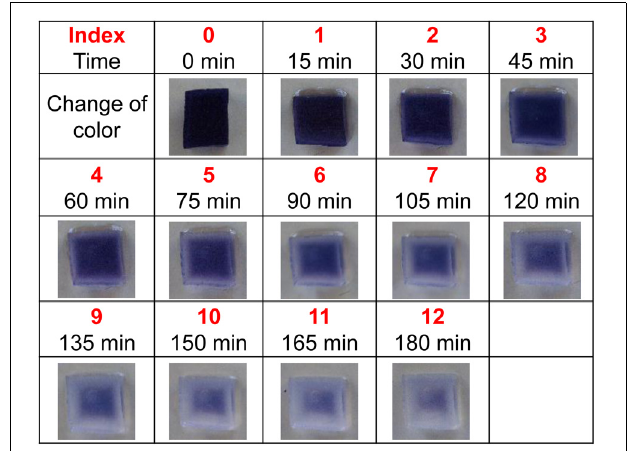
FIGURE 1 | Gradual digestion of starch after application of amylase. The change in color was recorded every 15min (for a total of 180min) and color intensity was indexed into 12 levels.